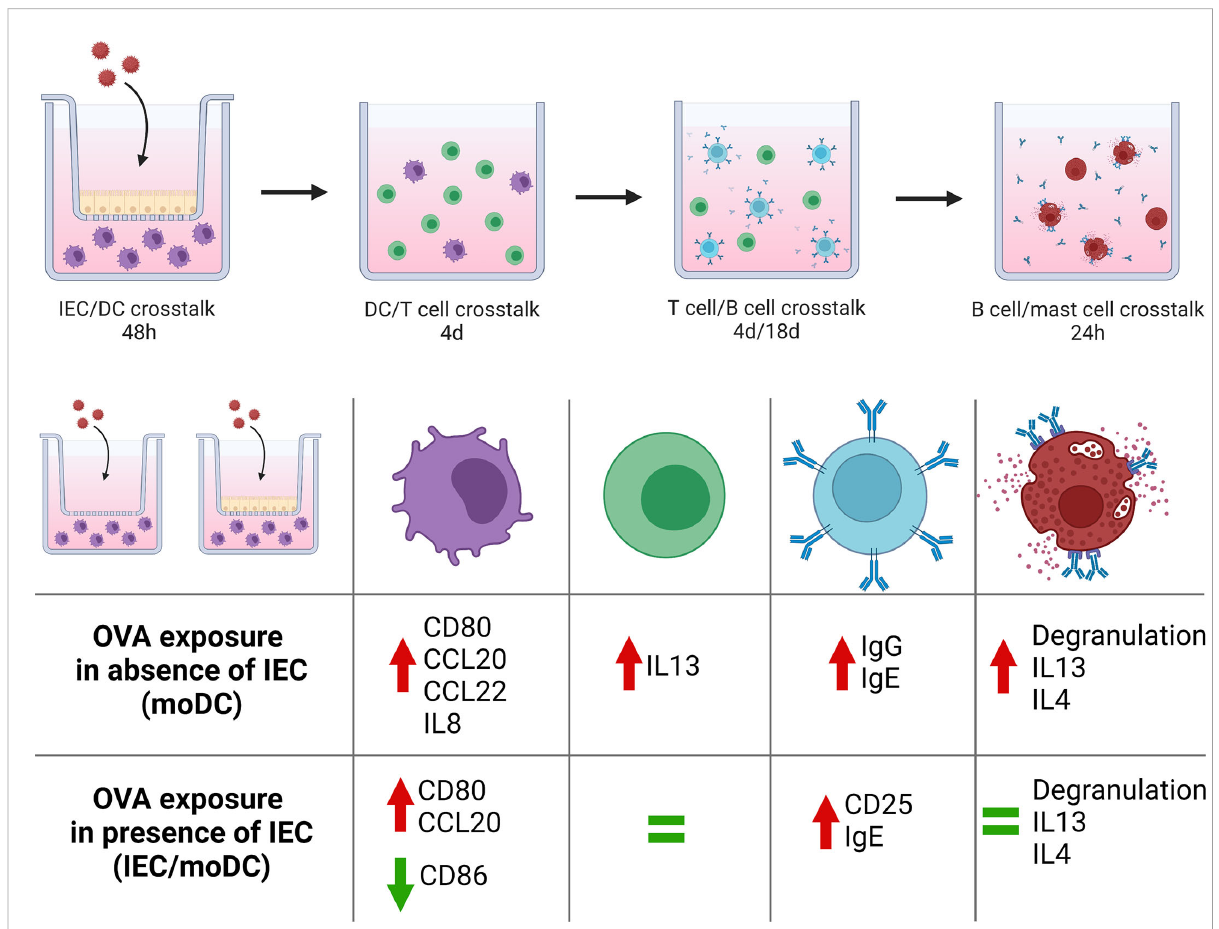
FIGURE 6 Schematic overview of the coculture steps from our novel sequential mucosal food sensitizing allergenicity model and fi ndings both in absence and presence of IEC during OVA exposure. OVA exposure in the absence of IEC resulted in mast cell activation downstream in the model, while the presence of IEC during OVA exposure did not result in mast cell activation despite the presence of IgE. This fi gure was created with